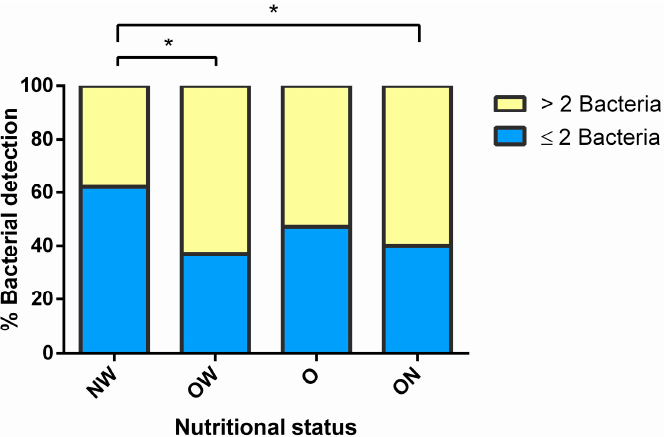
Figure 4. Distribution of nasopharyngeal bacterial detection according to nutritional status ( n = 116). Proportions were analyzed by a chi-square test. p < 0.05 was significant (*). NW, normal weight; OW, overweight; O, obese; ON, overnutrition.